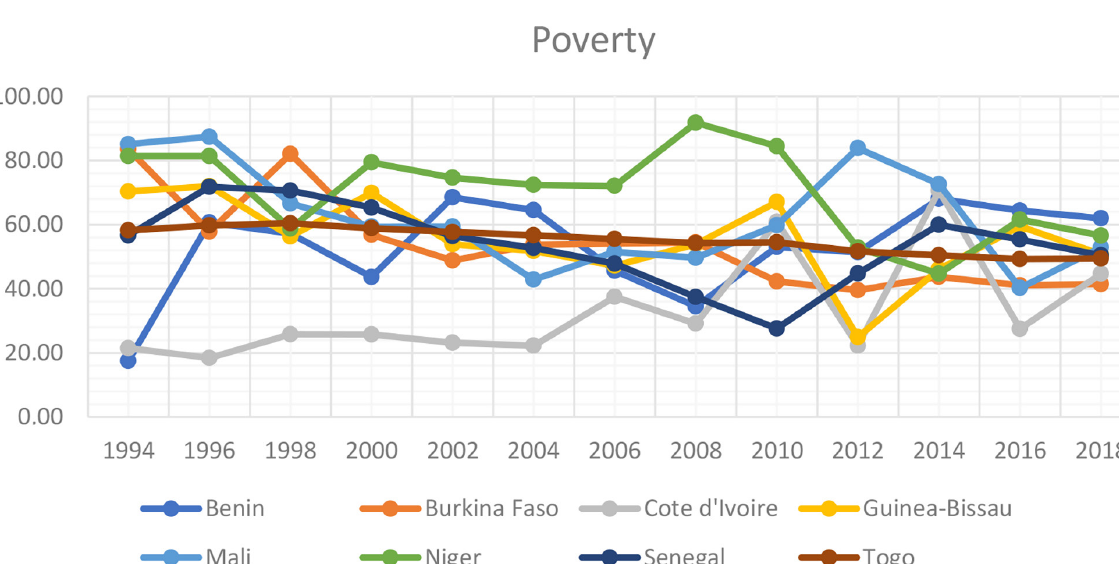
Fig. 3. Poverty headcount